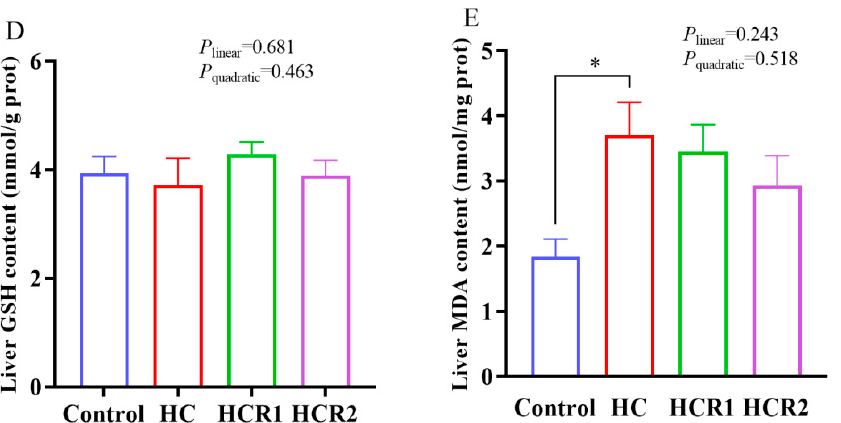
Figure 1. Liver T-SOD ( A ), CAT ( B ), and GPX ( C ) activities as well as GSH ( D ) and MDA ( E ) contents. Each data point represents the mean of four replicates (4 individuals per replicate). * Means p < 0.05, compared between the control and the HC group. ab Compared among the HC, HCR1, and HCR2 group. Bars assigned with different superscripts are significantly different ( p < 0.05). Control, diet with 32% nitrogen-free extract; HC, diet with 45% nitrogen-free extract; HCR1, diet with 45% nitrogen-free extract and 0.04% resveratrol; HCR2, diet with 45% nitrogen-free extract and 0.08% resveratrol. MDA, malondialdehyde; CAT, catalase; GSH, L-glutathione reduced; GPX, glutathione peroxidase; T-SOD, total superoxide dismutase.